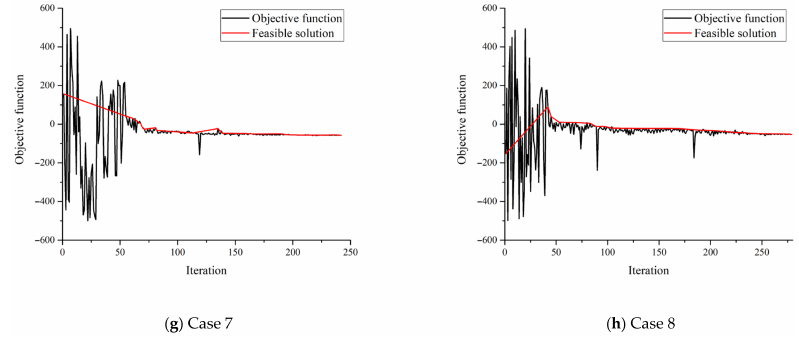
Figure 9. Convergence of the objective function.